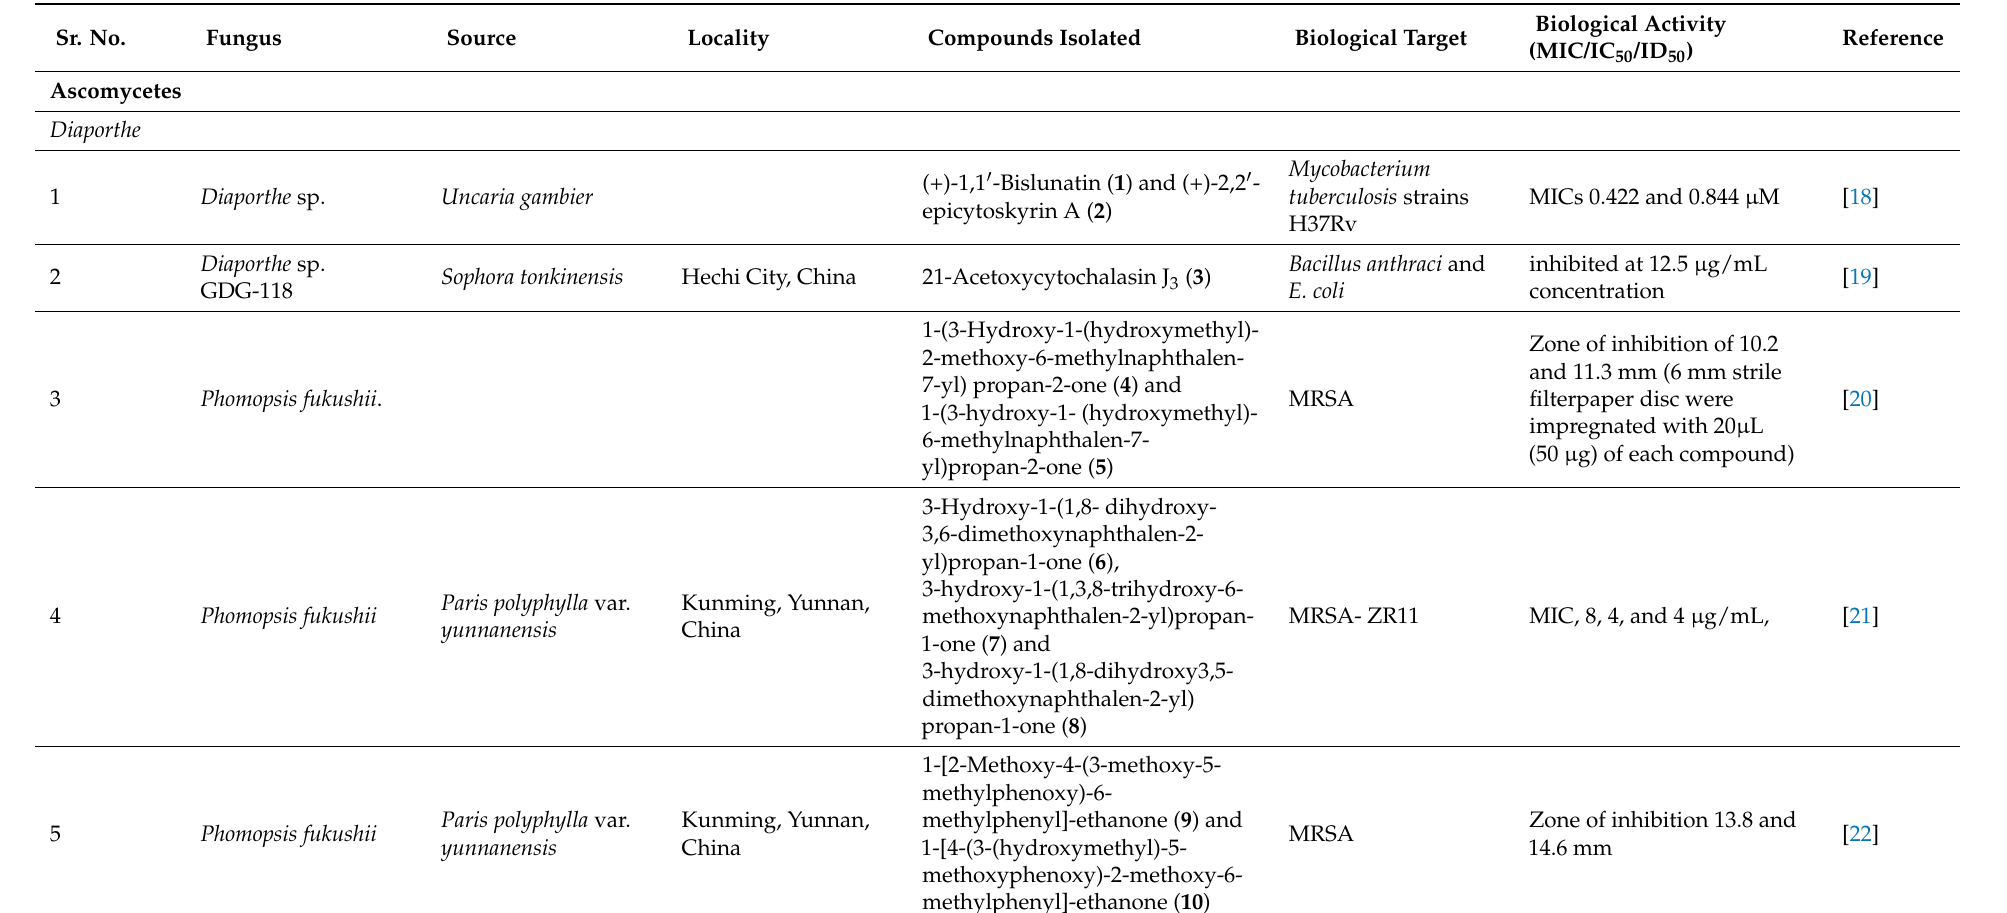
Table 1. Anti-bacterial metabolites reported from endophytic